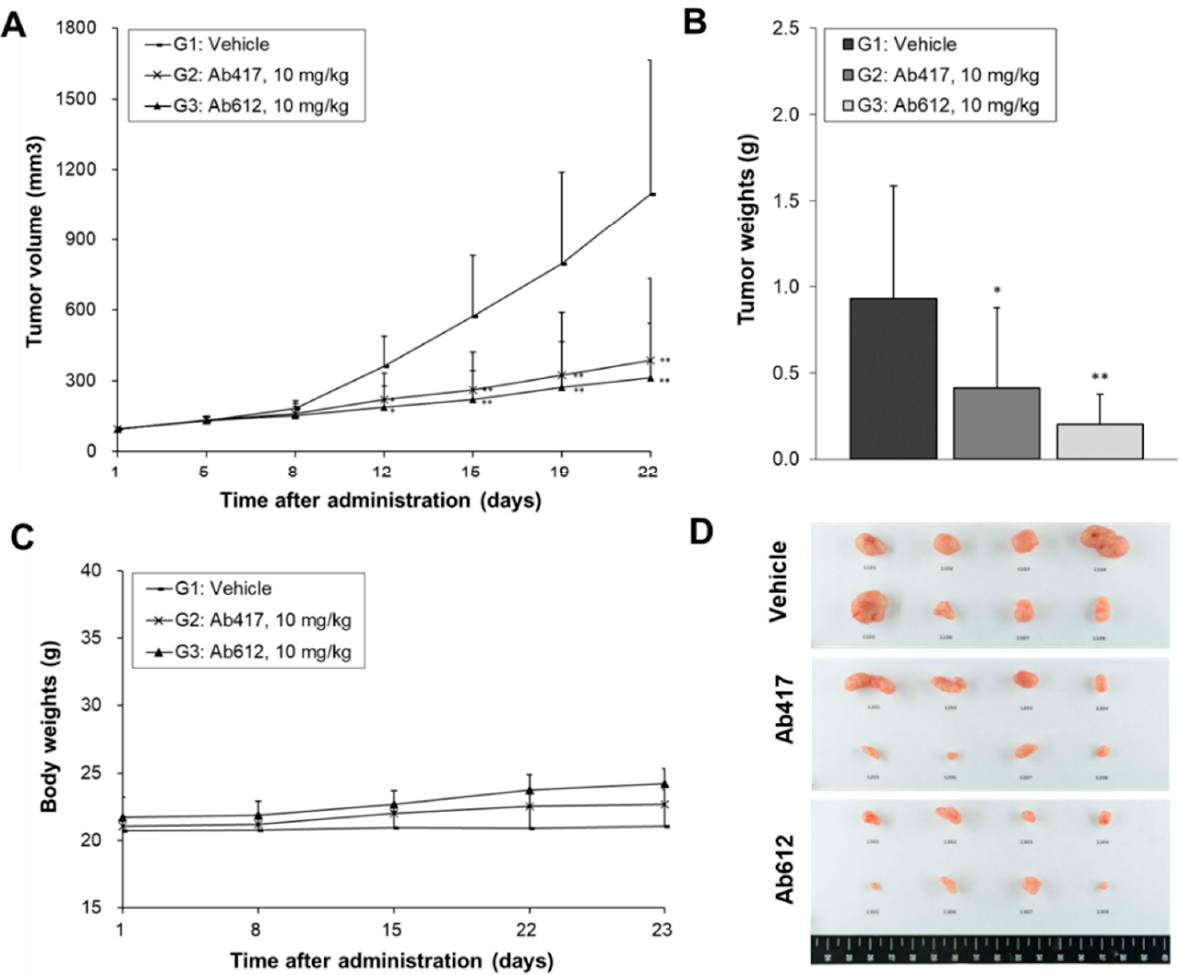
Figure 5. Anti-tumor efficacy of Ab612 compared with Ab417 in a Choi-Ck cholangiocarcinoma xenograft nude mouse model ( n = 8). When the tumor volume reached an average of 100 mm 3 , dosing (10 mpk) was initiated 3 times weekly for 22 days. Mean tumor volume ( A ), tumor weight ( B ), and body weight ( C ) are shown. ( D ) Photographs of the resected tumors at the end of the experiment. Each point represents the mean ± SD. * p < 0.05, ** p < 0.01, significant difference from the isotype control group by Dunnett’s t-test.